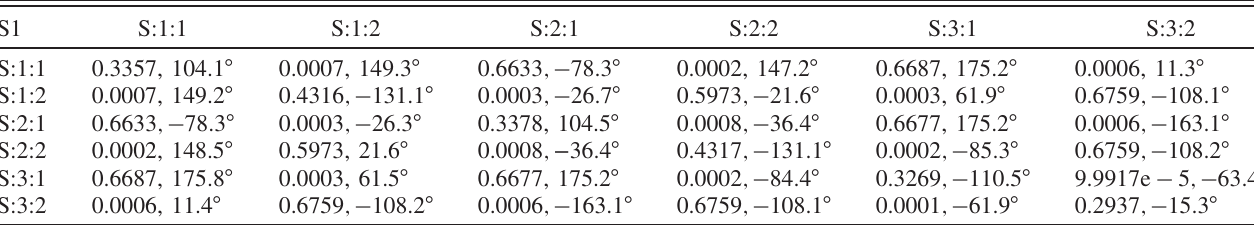
TABLE I. The scattering matrix of device in Fig.